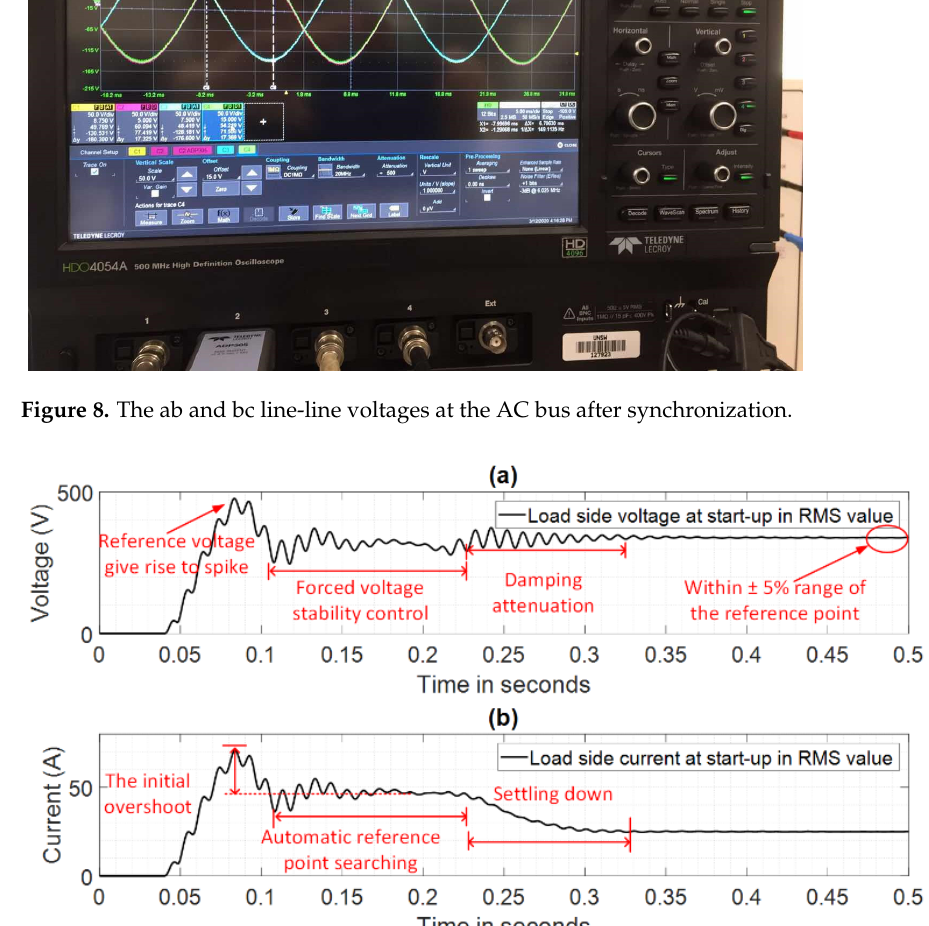
Figure 8. The ab and bc line-line voltages at the AC bus after synchronization.